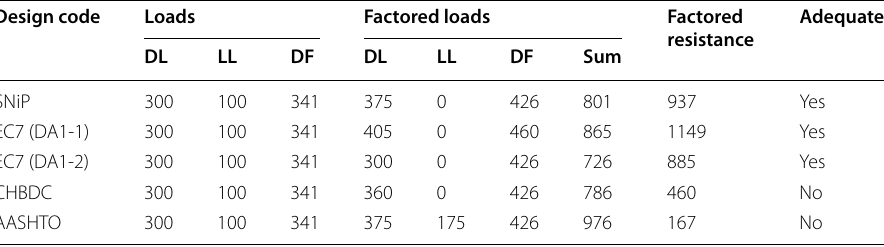
Table 5 Geotechnical ULS calculations according to design codes for Case III Design